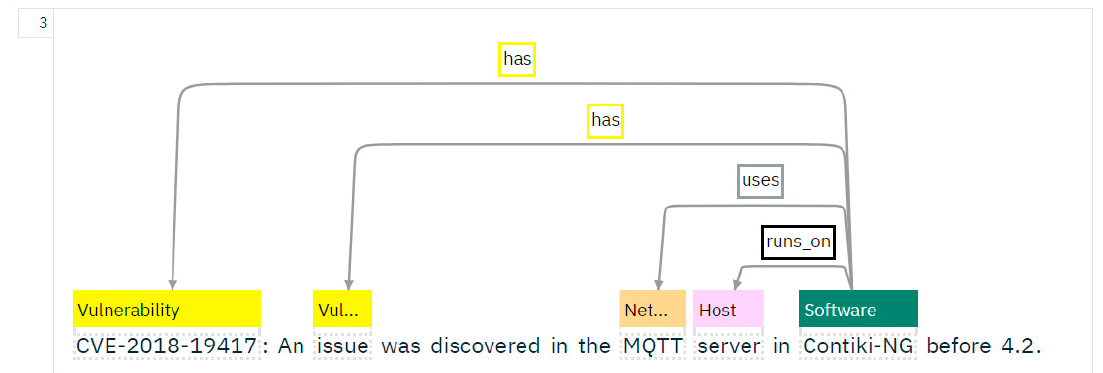
Figure 5. Training process from Knowledge Studio for relations recognition.